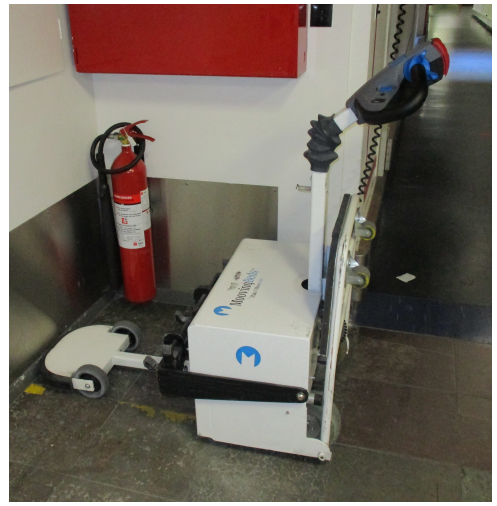
Figure 4: MoovingBeds , a supporting tool for the transportation of beds at Odense University